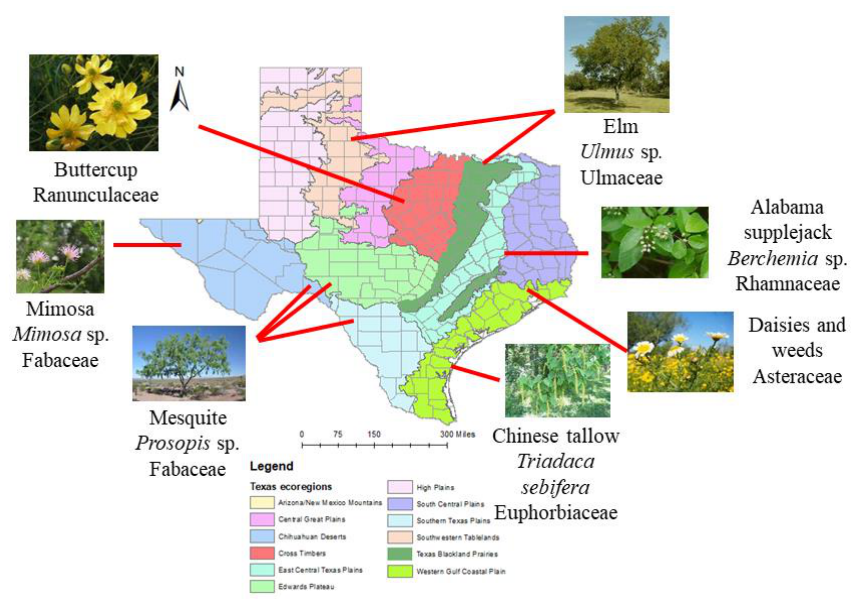
Figure 4. Notable taxa detected in honey from different ecoregions in Texas within